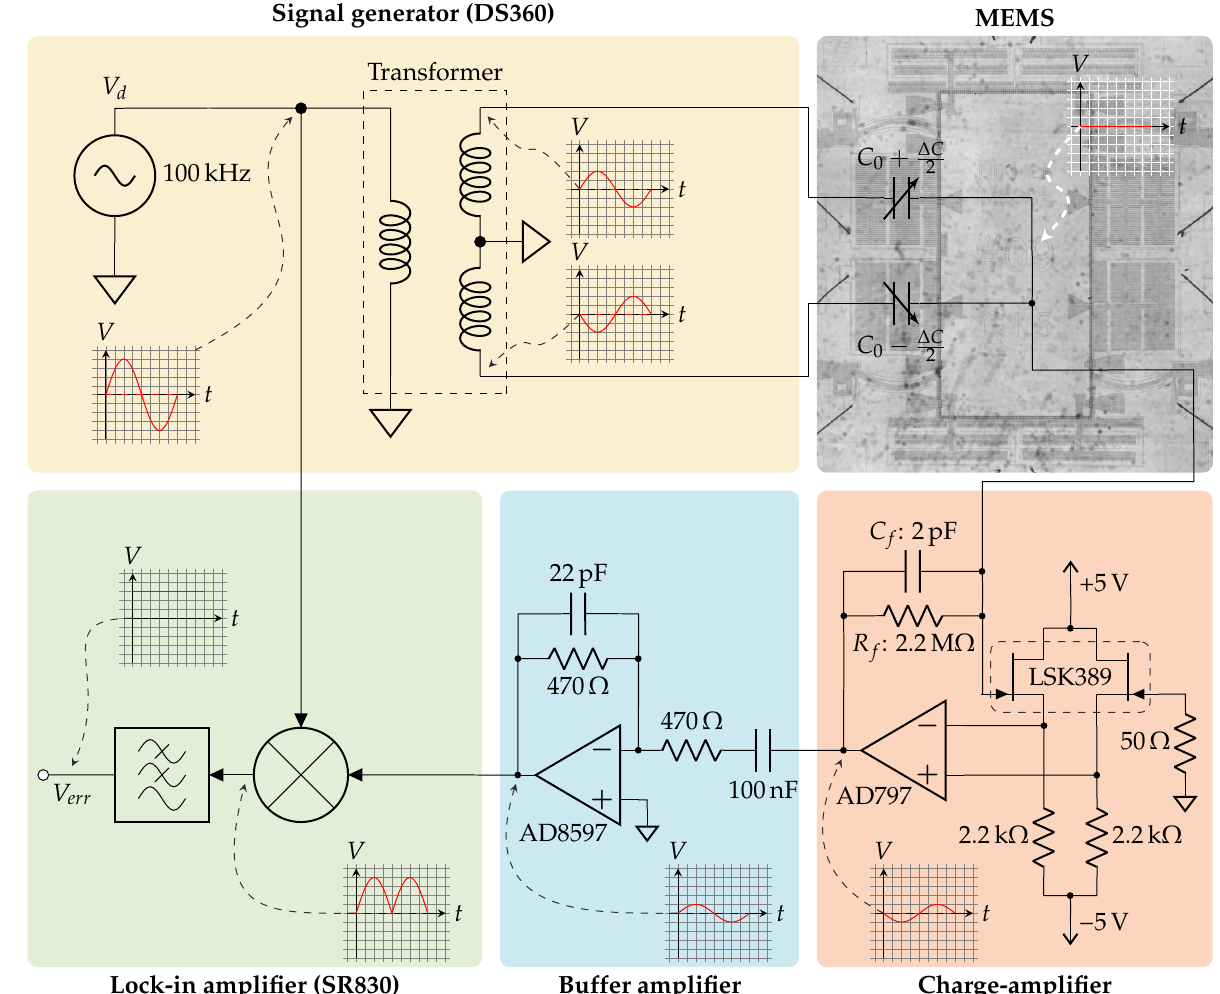
Figure 3. Schematic overview of the electronic system used to read the MEMS proof mass position. A transformer converts externally generated 100kHz sine with amplitude V d to a balanced signal driving the MEMS capacitor bridge. The residual bridge current is integrated by a charge-amplifier, and its output voltage is buffered and sent to an external lock-in amplifier for synchronous demodulation. The circuit produces a low-frequency signal V err proportional to ∆ C . The signals at different parts of the circuit are